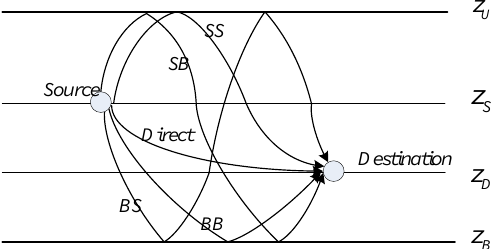
Figure 2. Multiple propagation paths for a pair of